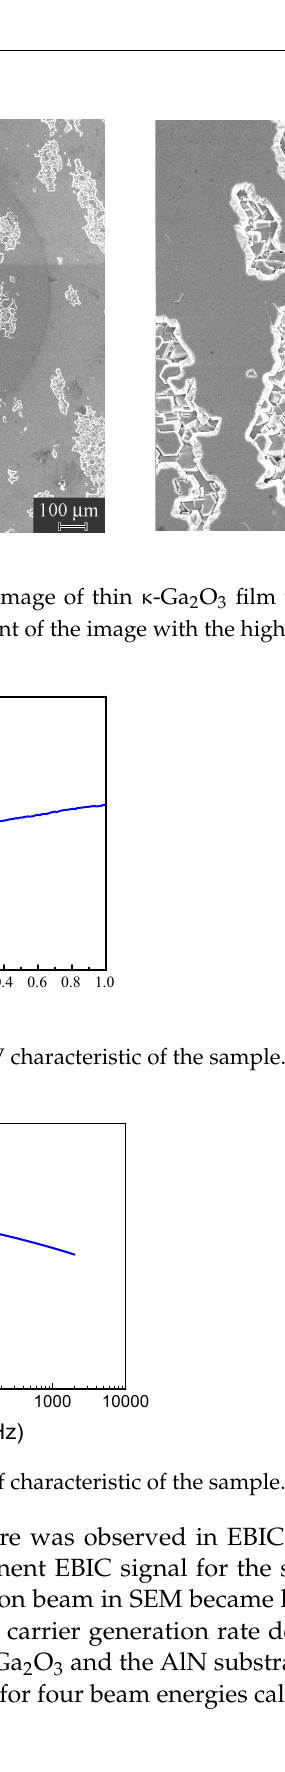
Figure 5. ( a ) Experimental C ‐ V characteristic, ( b ) modeled 1/C 2 versus V for three donor concen ‐ trations. Another unusual feature was observed in EBIC measurements on these Schottky diodes. Namely, the prominent EBIC signal for the structure appeared only when the energy of the probing electron beam in SEM became higher than 30 keV, corresponding to the peak in the excessive carrier generation rate dependence on z , h ( z ); this reached the interface between the κ‐ Ga 2 O 3 and the AlN substrate. Figure 6, illustrating this point, shows the h ( z ) dependences for four beam energies calculated using Equation (2). 0 39 keV Figure 6. Normalized carrier generation rate calculated for different probing beam energies. The dashed red line shows the film thickness.